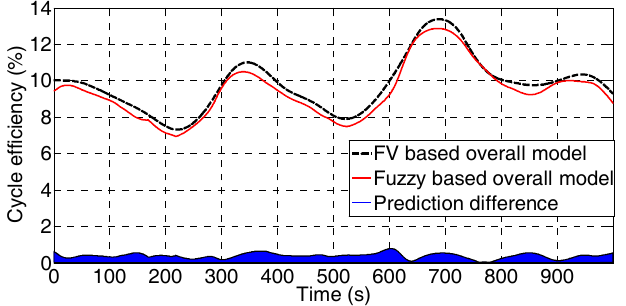
Figure 18. Cycle efficiency with respect to random inputs.